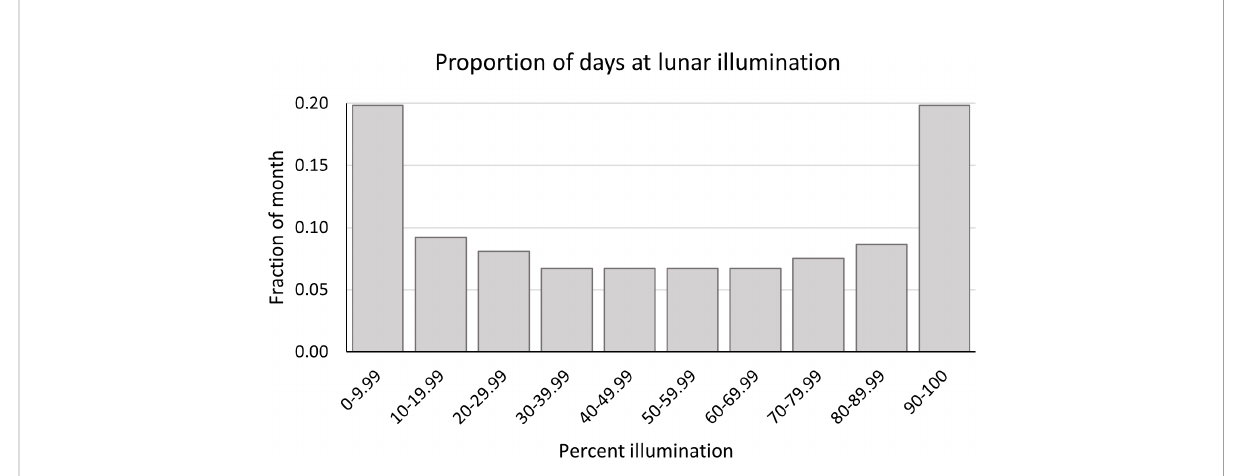
FIGURE 1 Proportion of days each month at lunar illumination split by decile based on 2021 data (USN